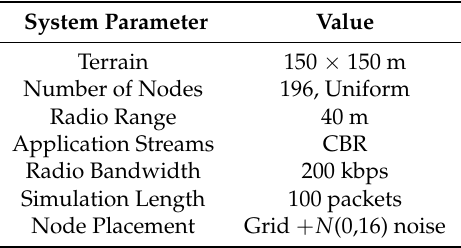
Table 1. Simulation